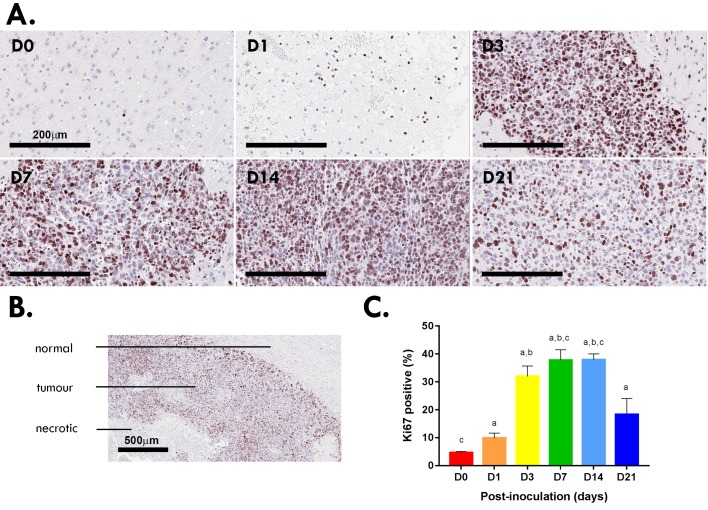
Ki67 proliferation index of Gl261 gliomas.Ki67+ staining at the inoculation site of murine Gl261 gliomas (A). Scale bar, 200μm. Tumors at day 21 post-inoculation showed signs of hypoxia/necrosis (B). Scale bar, 500μm. Quantitation of five HPF for each murine brain (N = 12 per time point; C). Data are expressed as mean ± SEM per HPF. ap<0.05 vs D0, bp<0.05 vs D1, cp<0.05 vs D21 by Tukey’s multiple comparison test.